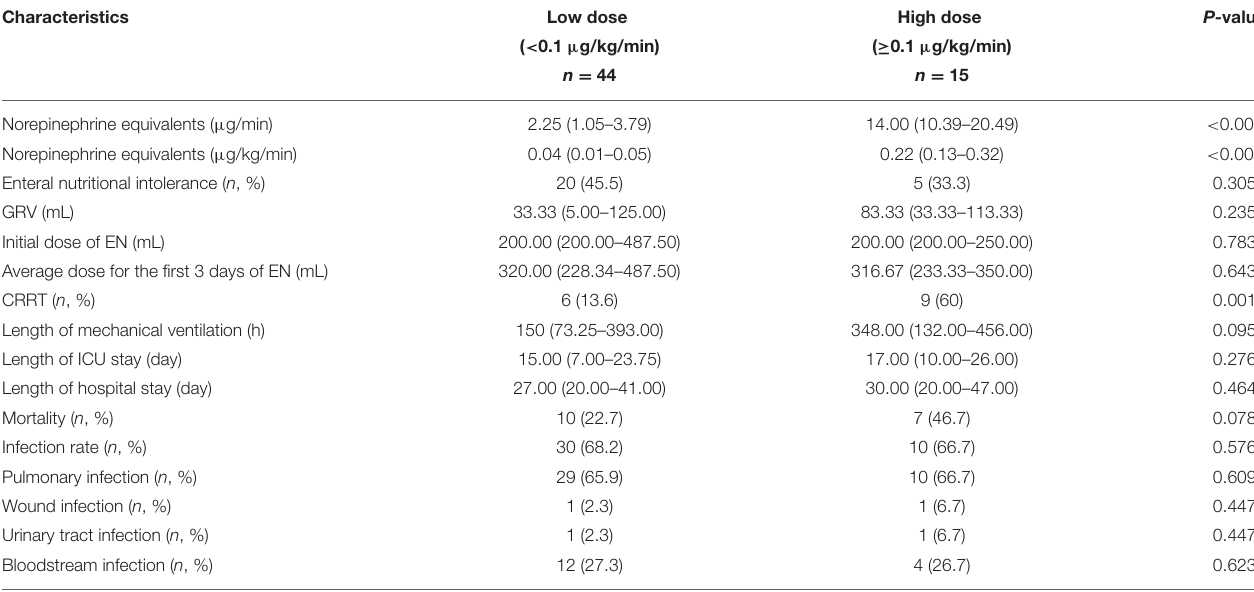
TABLE 6 | The primary and secondary outcome, grouped by the dose of norepinephrine equivalents. Characteristics